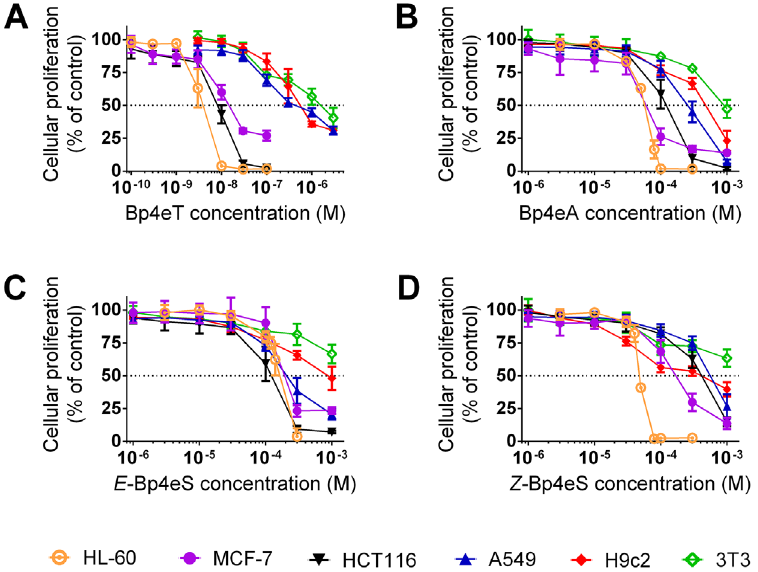
Fig 2. Anti-proliferative activity of Bp4eT (A) and its metabolites, Bp4eA (B), and both E (C) and Z (D) isomers of Bp4eS. For determination of anti-proliferative activity, the cancer cell lines ( i . e ., HL-60, MCF-7, HCT116 and A549) and non-cancer cell lines ( i . e ., H9c2 and 3T3) were incubated with the agents for 72 h/ 37°C and proliferation then assessed using the MTT assay. The results are mean ± SD ( n (cid:1) 4